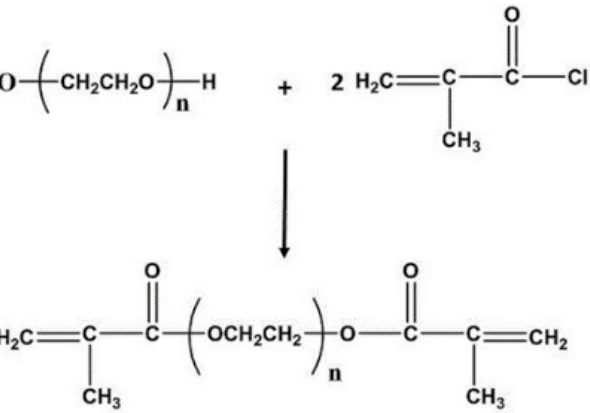
Scheme 1. The vinylization reaction scheme of polyethyleneglycol with methacryloyl